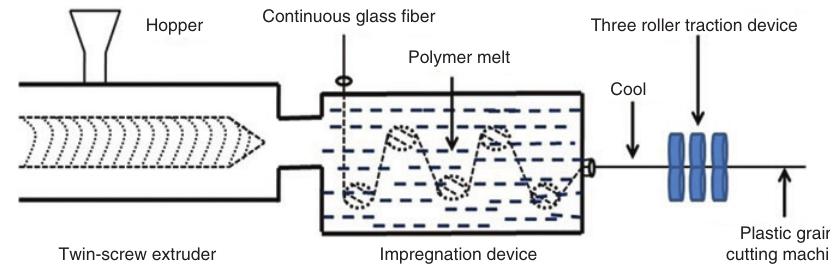
Figure 2 The melt-impregnation process of the LGF/TPU/ABS composites.